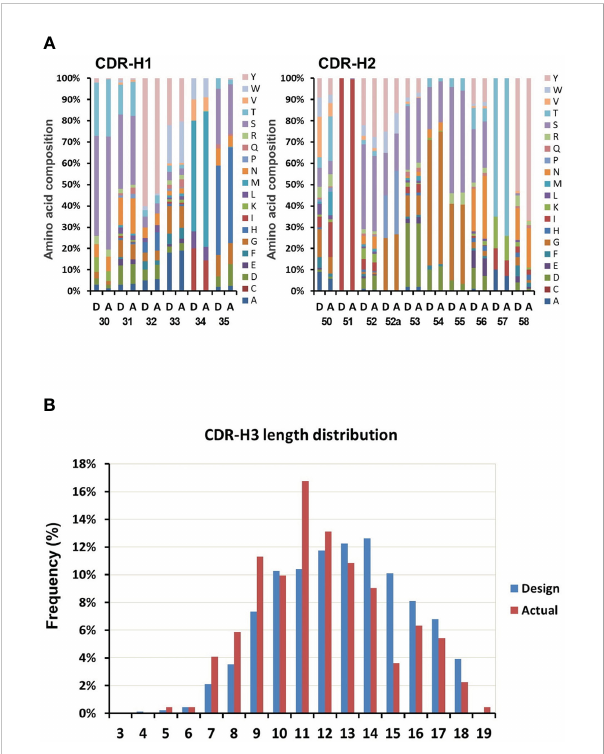
FIGURE 4 Variability assessment of the library. The variability in the designed library is compared with the variability found from sequencing 300 clones of the actual constructed library. (A) Comparison between designed (D, left columns) and actual (A, right columns) composition of CDRs (CDR1 and CDR2 as example). (B) The length distribution of the designed (D, left columns) and the actual (A, right columns)